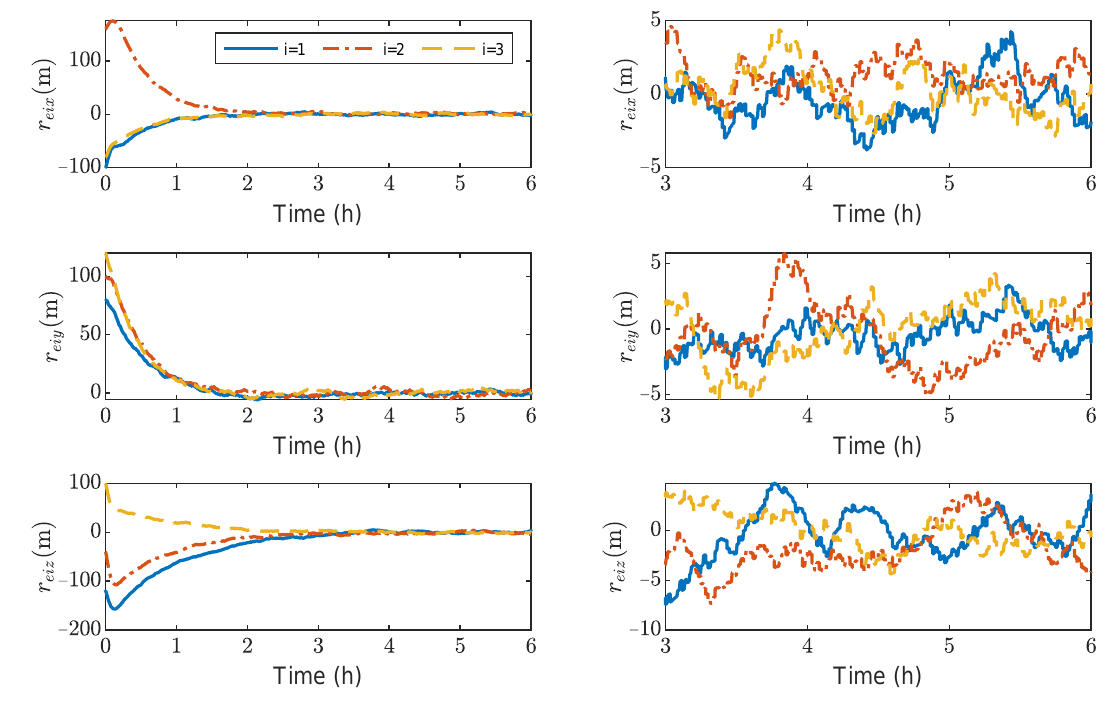
Figure 13. Relative position errors of spacecraft SC1 ∼ 3, the max control force of spacecraft is 100 mN.